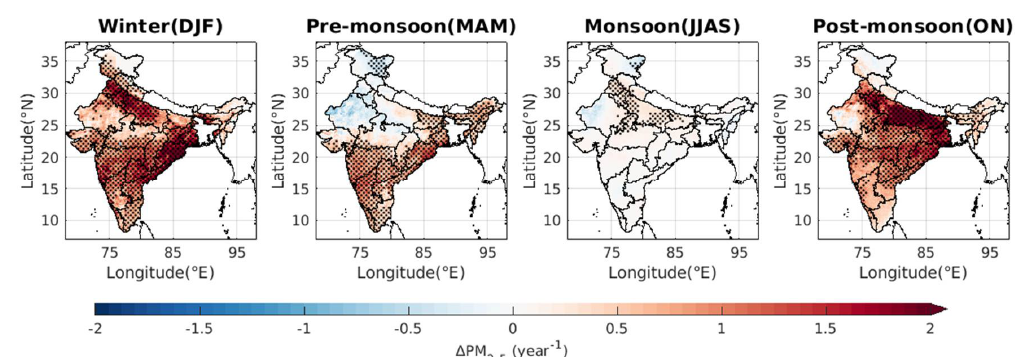
Figure 8. Spatial patterns of the annualized rate of changes in seasonal PM 2.5 (in µ g / m 3 per year) over India during the last 20 years. The statistically significant trends (p<0.05) are identified as stippled marks.